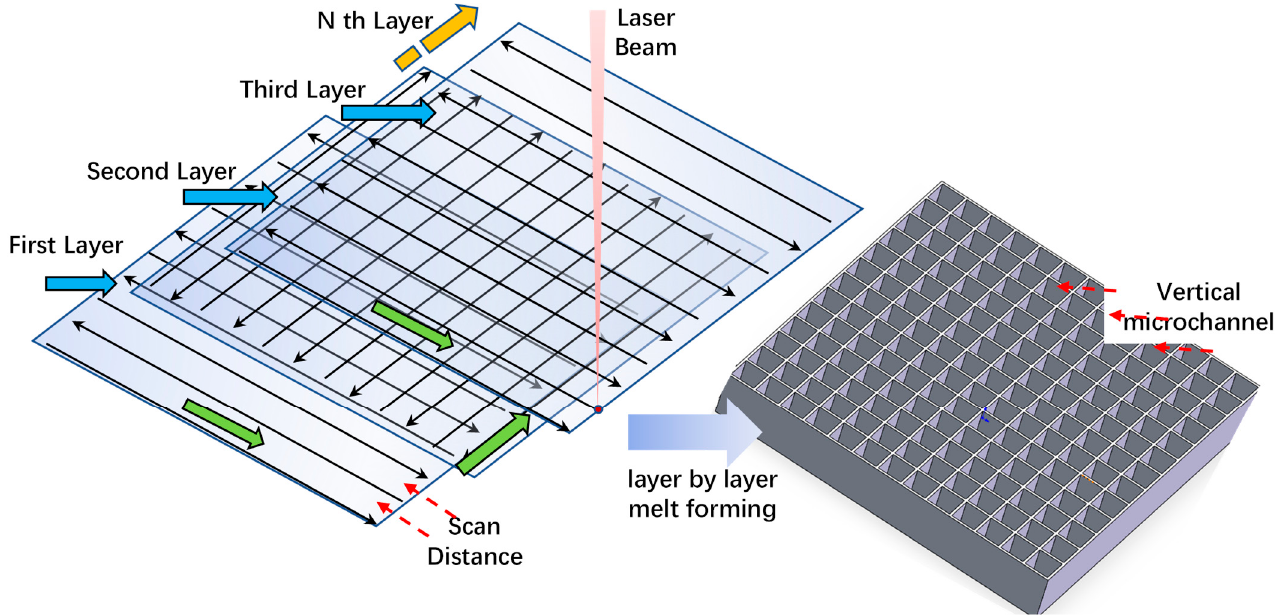
Figure 1. The principle of forming a grid structure using the L-PBF technique; transverse and longitudinal scanning was alternately performed, forming a large number of neatly arranged square holes.